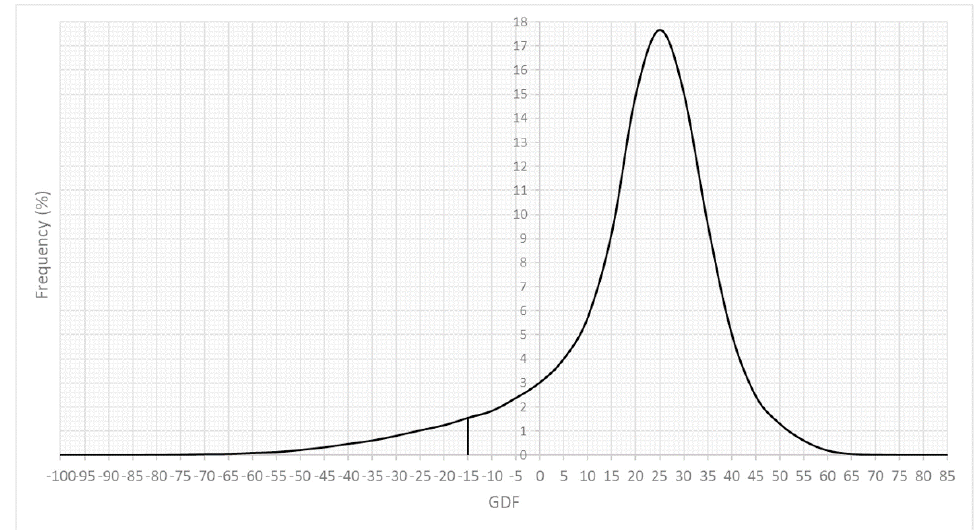
Figure 1. Frequency distribution of the GDF index at the last examination of each eye. Zero is approximately the minimum value in 5% of the normal population, and − 15 is the value in 1% of the normal population.